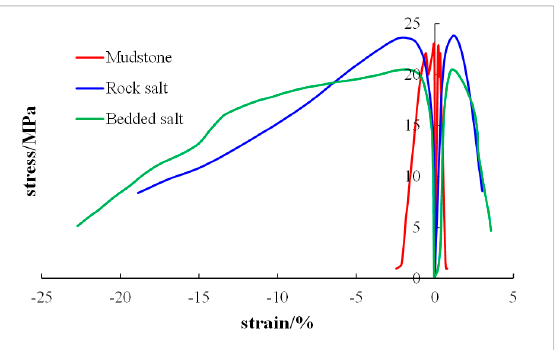
Figure 1. Stress ‐ strain curves of mudstone, rock salt and bedded salt in uniaxial compression tests.